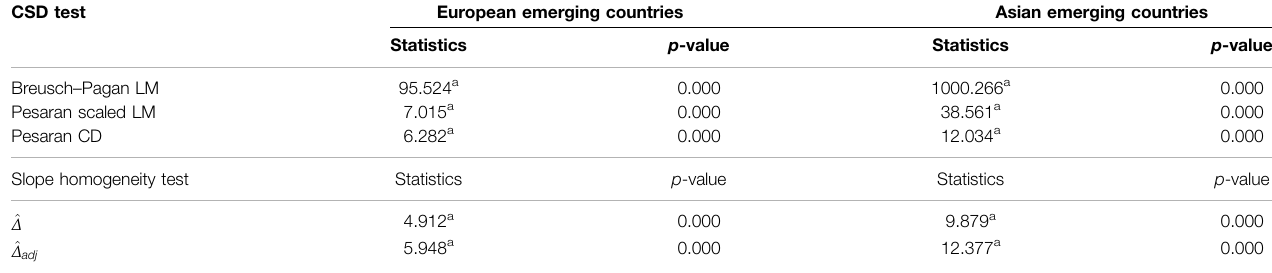
TABLE 1 | CSD and slope homogeneity test results CSD